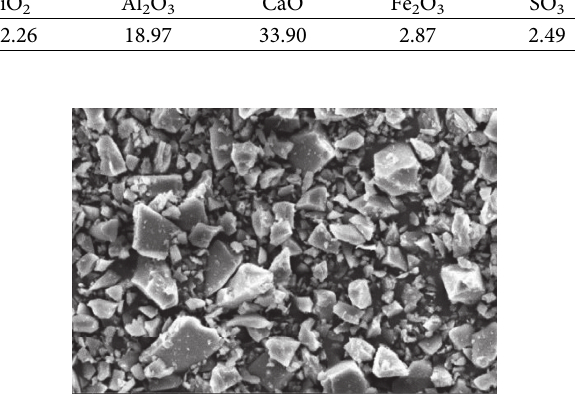
Figure 1: SEM image of the nickel slag powder (magnification: 5000x).